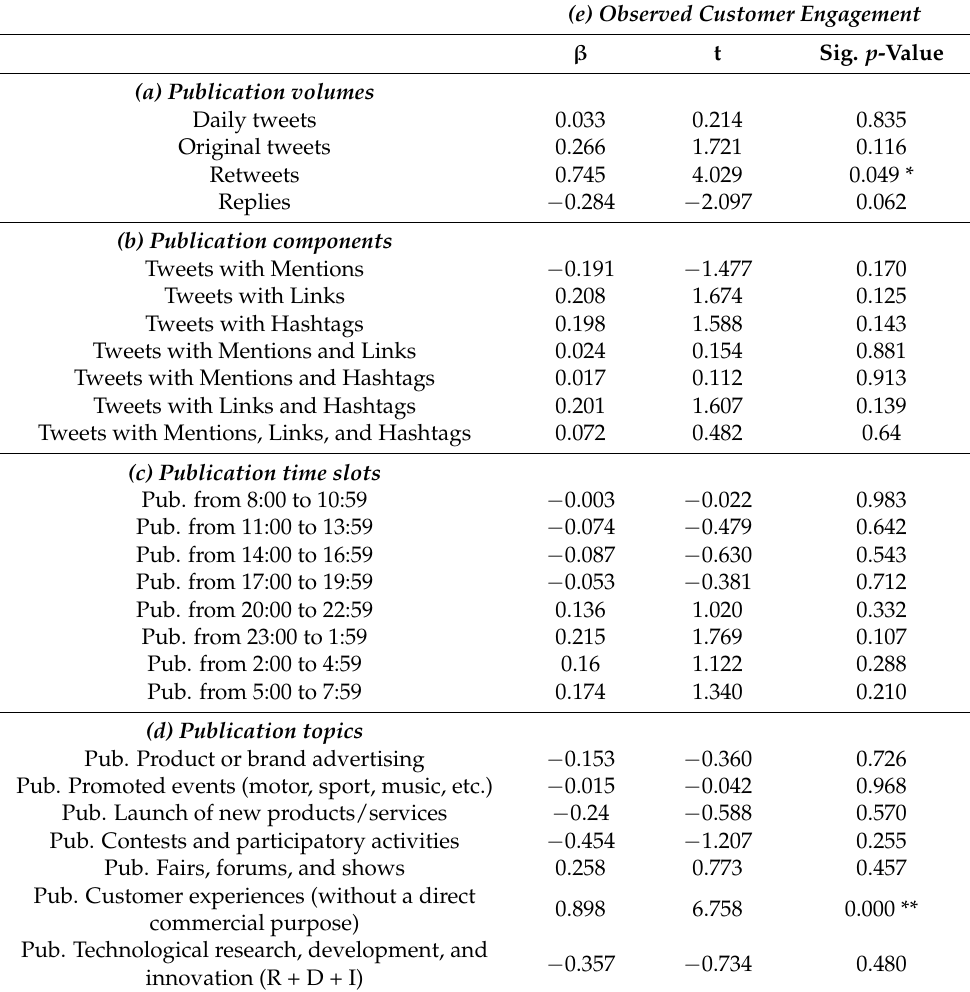
Table 3. Multiple linear regression